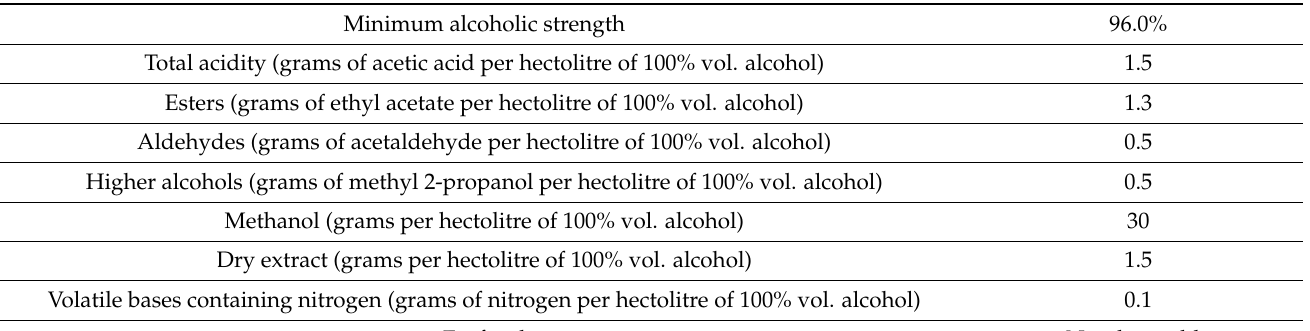
Table 1. Requirements of neutral spirit constituents used in the production of spirit drinks. The requirements listed are in accordance with European Union regulations (EU 2019/787 Ethyl Alcohol of Agricultural Origin) (Adapted from